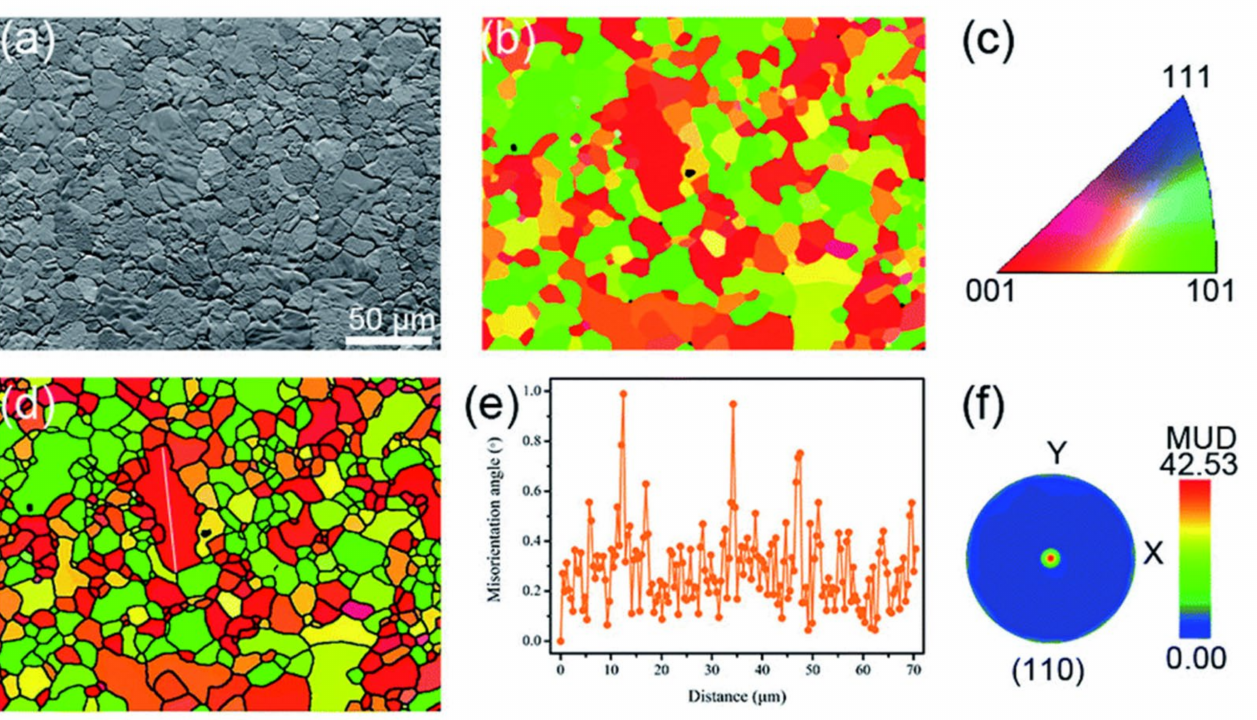
Figure 14. ( a ) Backscattered electron (BSE) image; ( b ) X-axis inverse pole figure (IPF) (parallel to the sample surface); ( c ) the standard color orientation reference system; ( d ) grain identified from the IPF map with a 2 ◦ orientation threshold; ( e ) point-to-point misorientation profile along the white line in ( d ); ( f ) pole density figure. The color bar represents multiples of random distribution of orientations. Reprinted with permission from Ref. [152]. Copyright 2021 Royal Society of